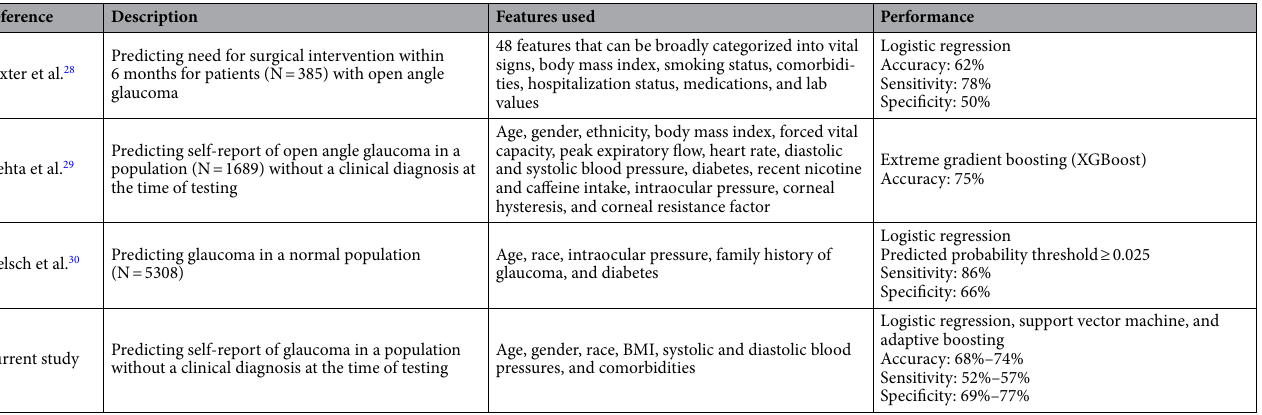
Table 4. Summary of artificial intelligence-based glaucoma risk prediction models that do not use visual fields and imaging